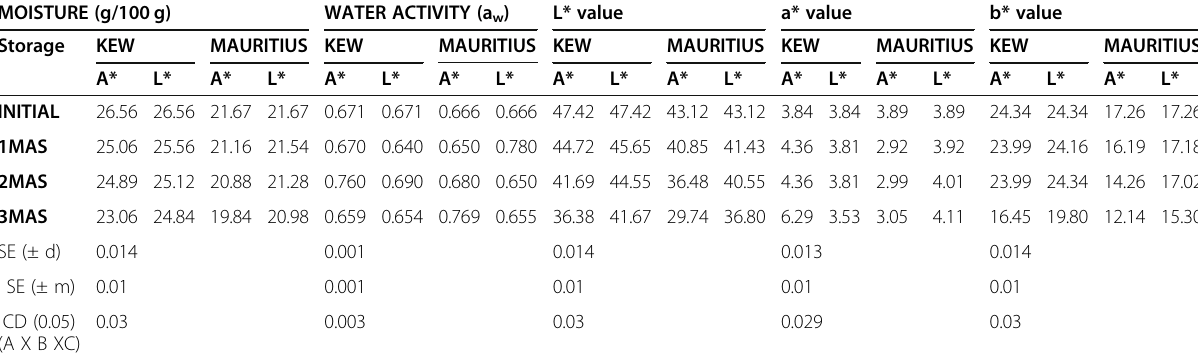
Table 1 Moisture (g/100 g), water activity (a w ), colour values (L*, a*, b*) of intermediate moisture pineapple slices during storage MOISTURE (g/100